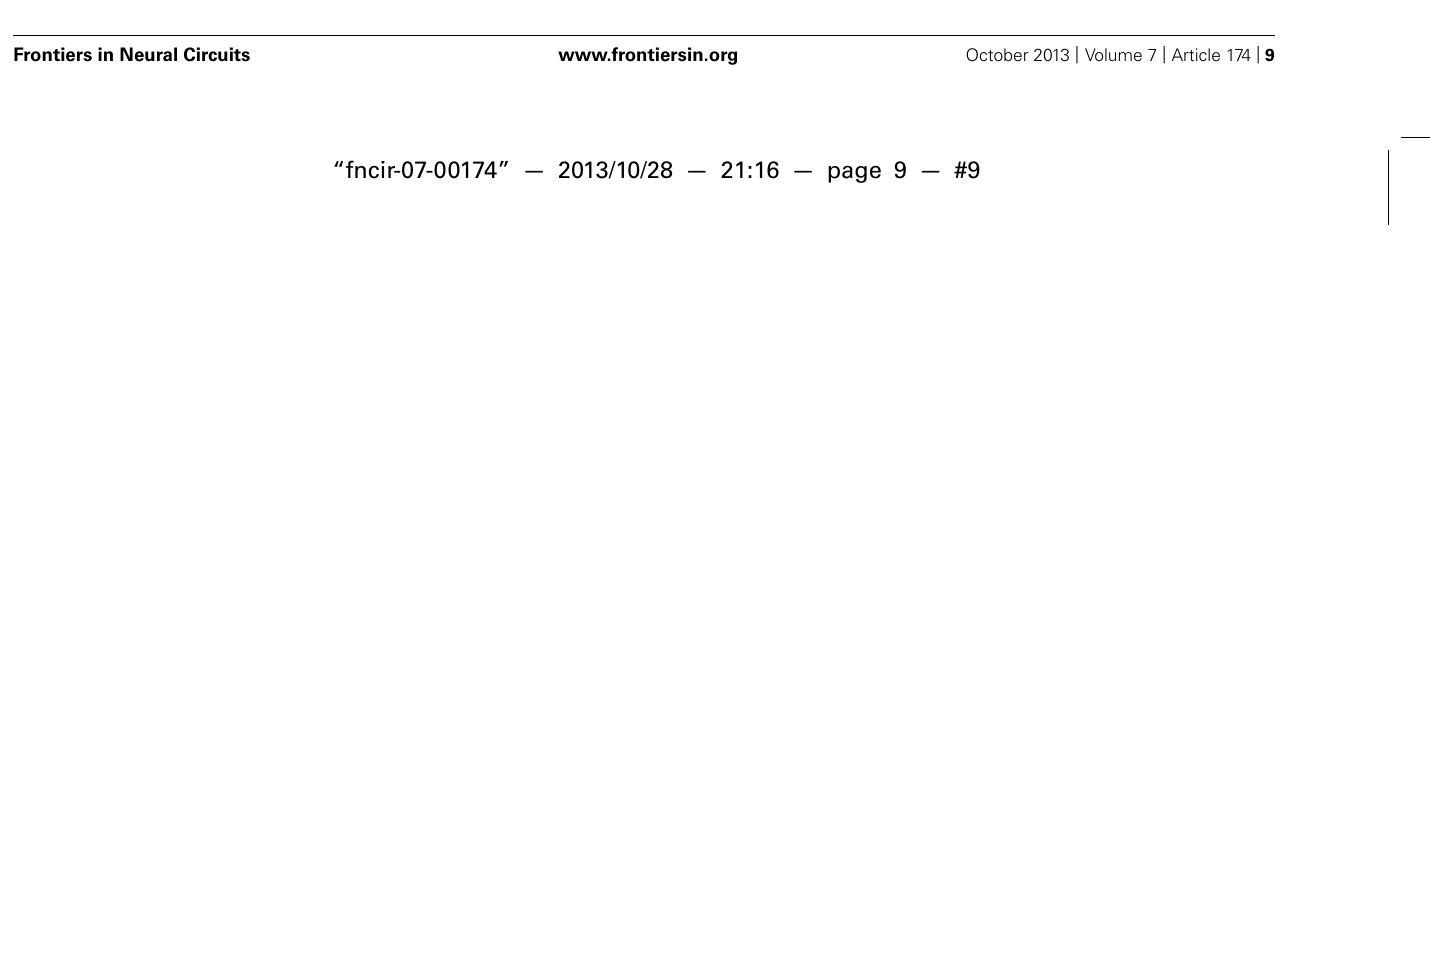
FIGURE 5 | Monosynaptic excitation and inhibition in wide dynamic range neurons. (A) Spike rasters. Firing rates decrease in HiDi (middle), but increase again in the inhibitory antagonists (bottom). Gabazine (Gz, 50 μ M); strychnine (8 μ M).The inhibition is a monosynaptic input. (B) RIFs for the cell in (A) .The RIF in HiDi/Gz,/strychnine, due to the excitatory component of the monosynaptic input increases throughout the range of intensities, unlike the